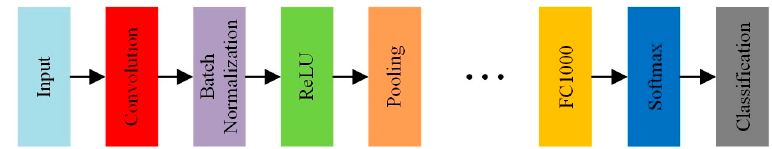
Figure 3. The architecture of the adjusted deep-learning models